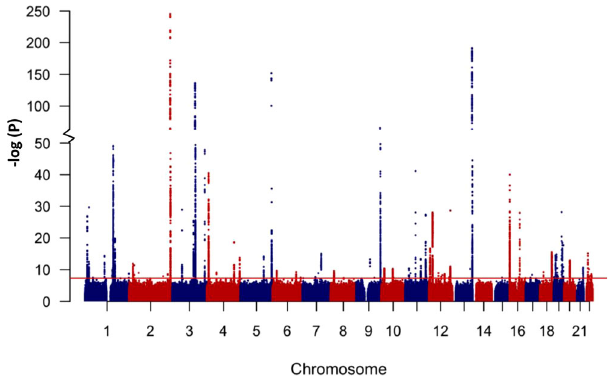
Fig. 2 Manhattan plot of GWAS results from 45 clinically-relevant traits. The chromosomal position of genetic variants ( N = 7,880,618) is plotted against – log 10 (P). Analysis was performed using linear mixed models correcting for age, sex, population principal components and relatedness. The red horizontal line represents the threshold for genome-wide signi fi cance ( P < 5.0 × 10 − 8